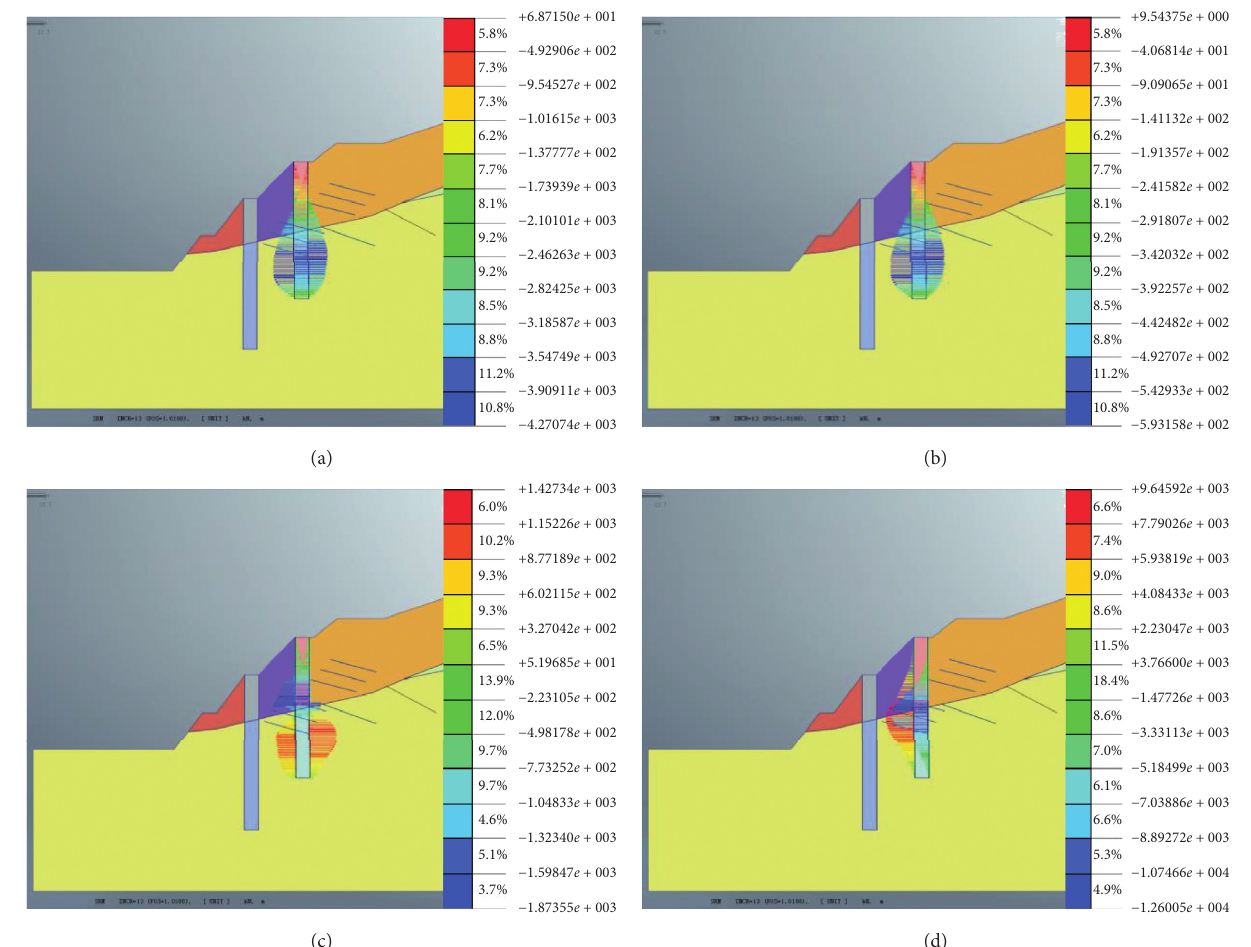
Figure 11: Cloud diagrams of antislide piles when considering steady-state seepage: (a) axial force; (b) axial stress; (c) shear force; (d) bending